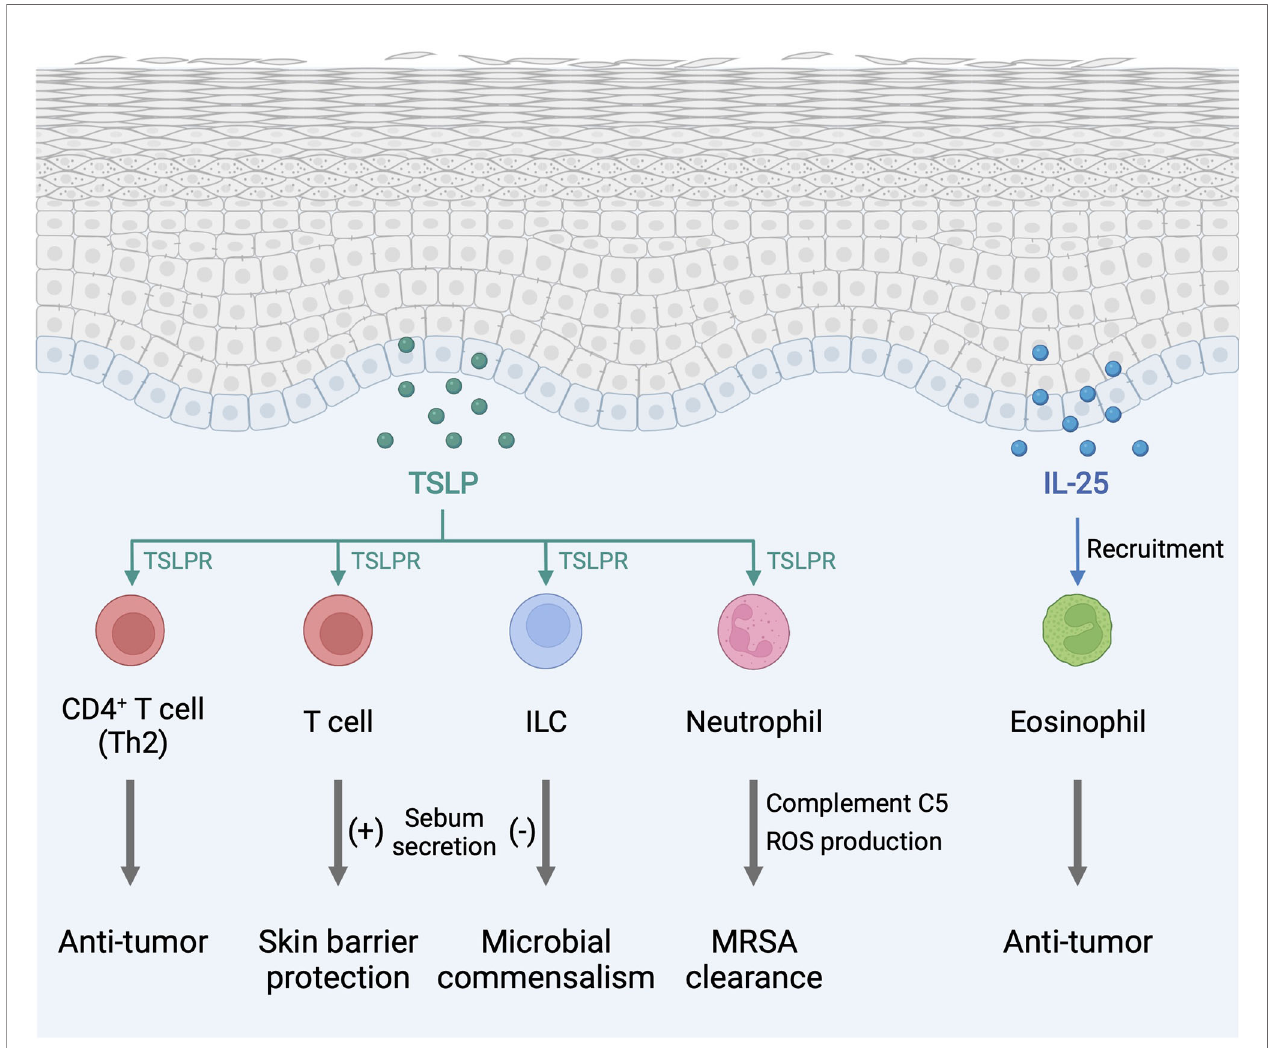
FIGURE 2 | Type 2 alarmin cytokines exhibit pro-homeostatic properties in the skin. The function of type 2 alarmin cytokines extends beyond their conventional Th2-associated function in host defense and allergy. In the skin, these cytokines play critical roles in cancer regulation and sebum secretion. ILC, innate lymphoid cell; MRSA, methicillin-resistant Staphylococcus aureus ; ROS, reactive oxygen species; TSLP, thymic stromal lymphopoietin; TSLPR, thymic stromal lymphopoietin receptor. Created with